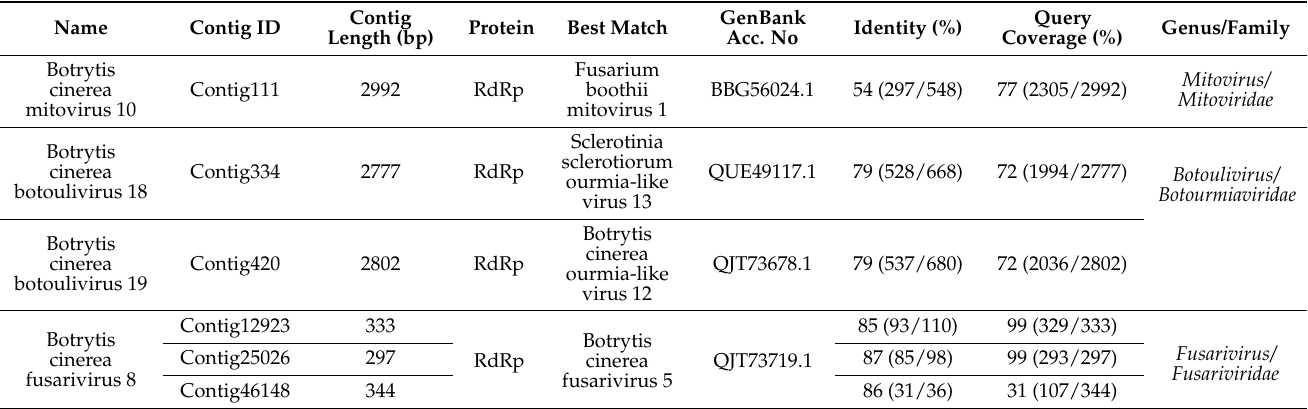
Table 1. Information for the assembled contigs of mycoviruses obtained from high-throughput sequencing analysis of the Botrytis cinerea SZ-2-3y strain.